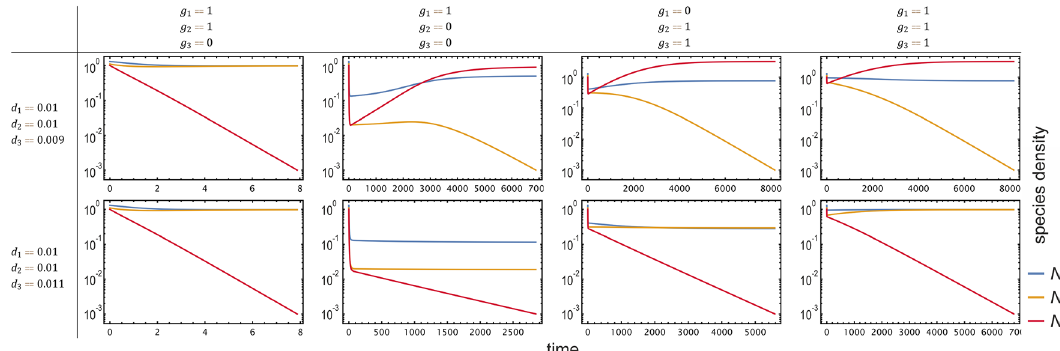
Figure 3. Time evolution of a cross-feeding partnership with waste product inhibition with a mutant species appearing (red), depending on the directionality of cross-feeding ( g ) and mortality ( d ). We assume that species 3 (a mutant of species 2, yellow) inherits the resource utilization of species 2 ( g 3 = g 2 , except in the first column). The x -axis represents time, the y -axis represents density on a logarithmic scale. Species 1 and 2 cause the mutant species 3 to go extinct whenever d 2 < d 3 , even if there is no cross-feeding at all. That is, the apparent survival of producers against cheaters is not because of cross-feeding but because of the higher assumed mortality for cheaters. When there is cross-feeding between species 1 and 2 ( g 1 = g 2 = 1, g 3 = 0 ), coexistence of species 1 and 2 is independent of the ratio of d 1,2 / d 3 . That is, species 3 has no chance